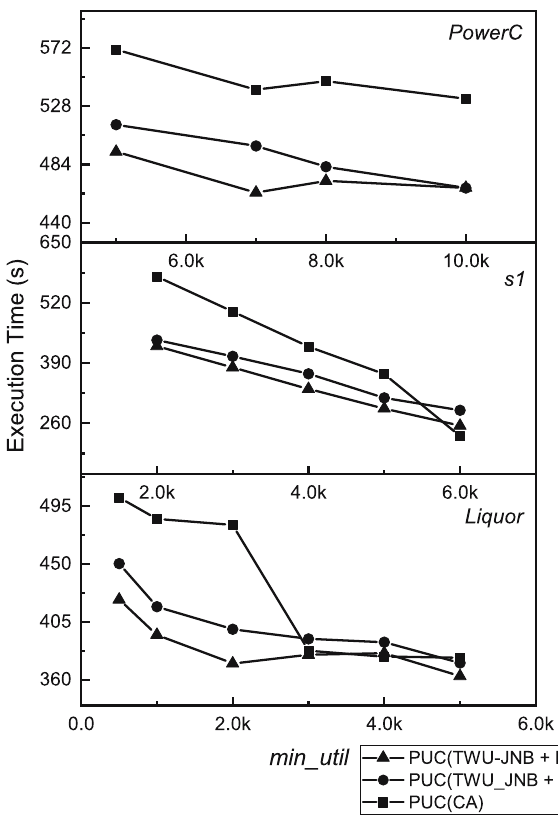
Figure 5: Comparison of di ff erent assignment strategies for PUC.